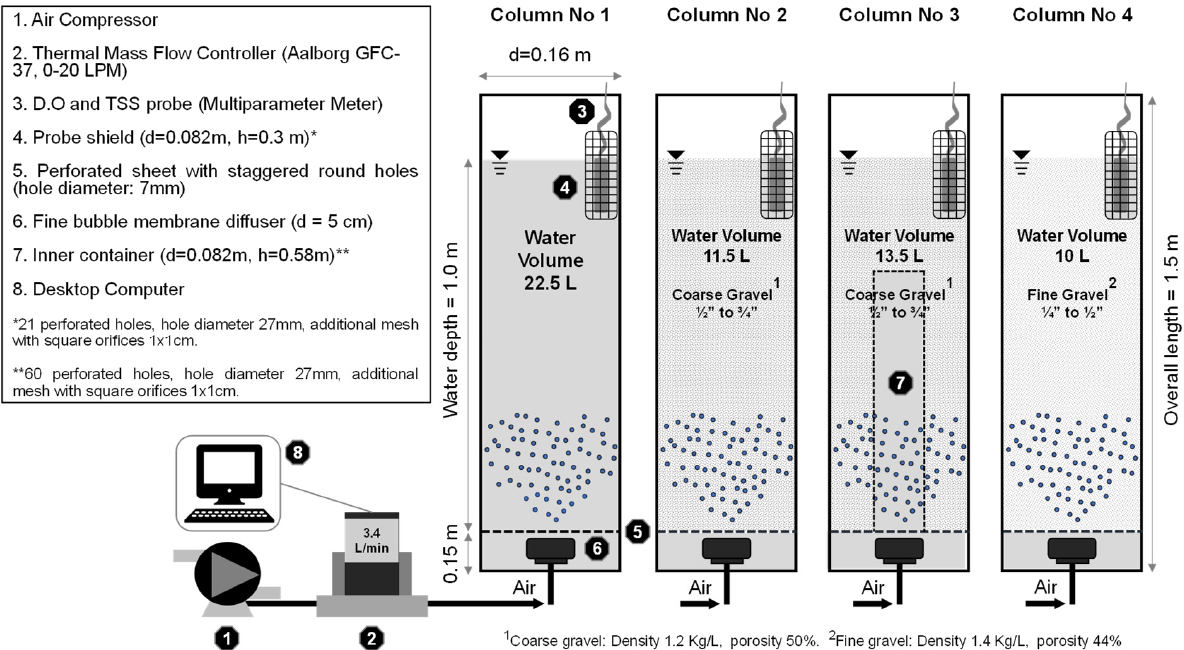
Figure 1. Schematic diagram of the bench-scale testing columns (not to scale).